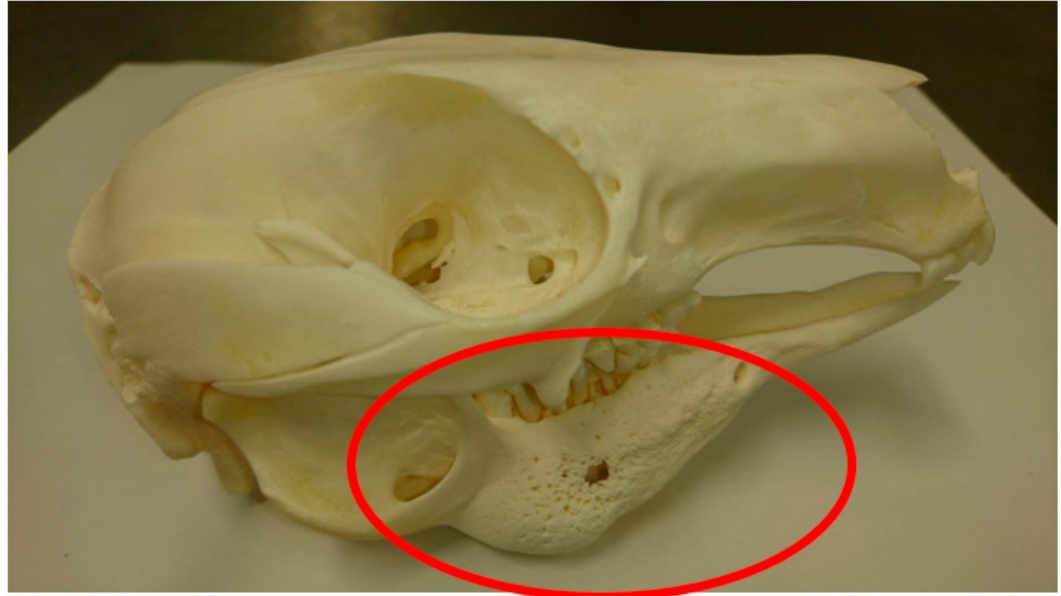
Figure 2. Osteoproliferation consistent with osteomyelitis in the mandibular bone of a western grey kangaroo ( Macropus fuliginosus ). (Image courtesy of P. Dobbs, Twycross